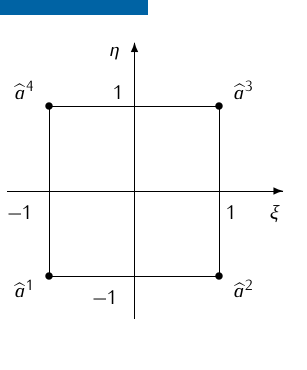
Figure 2. The reference